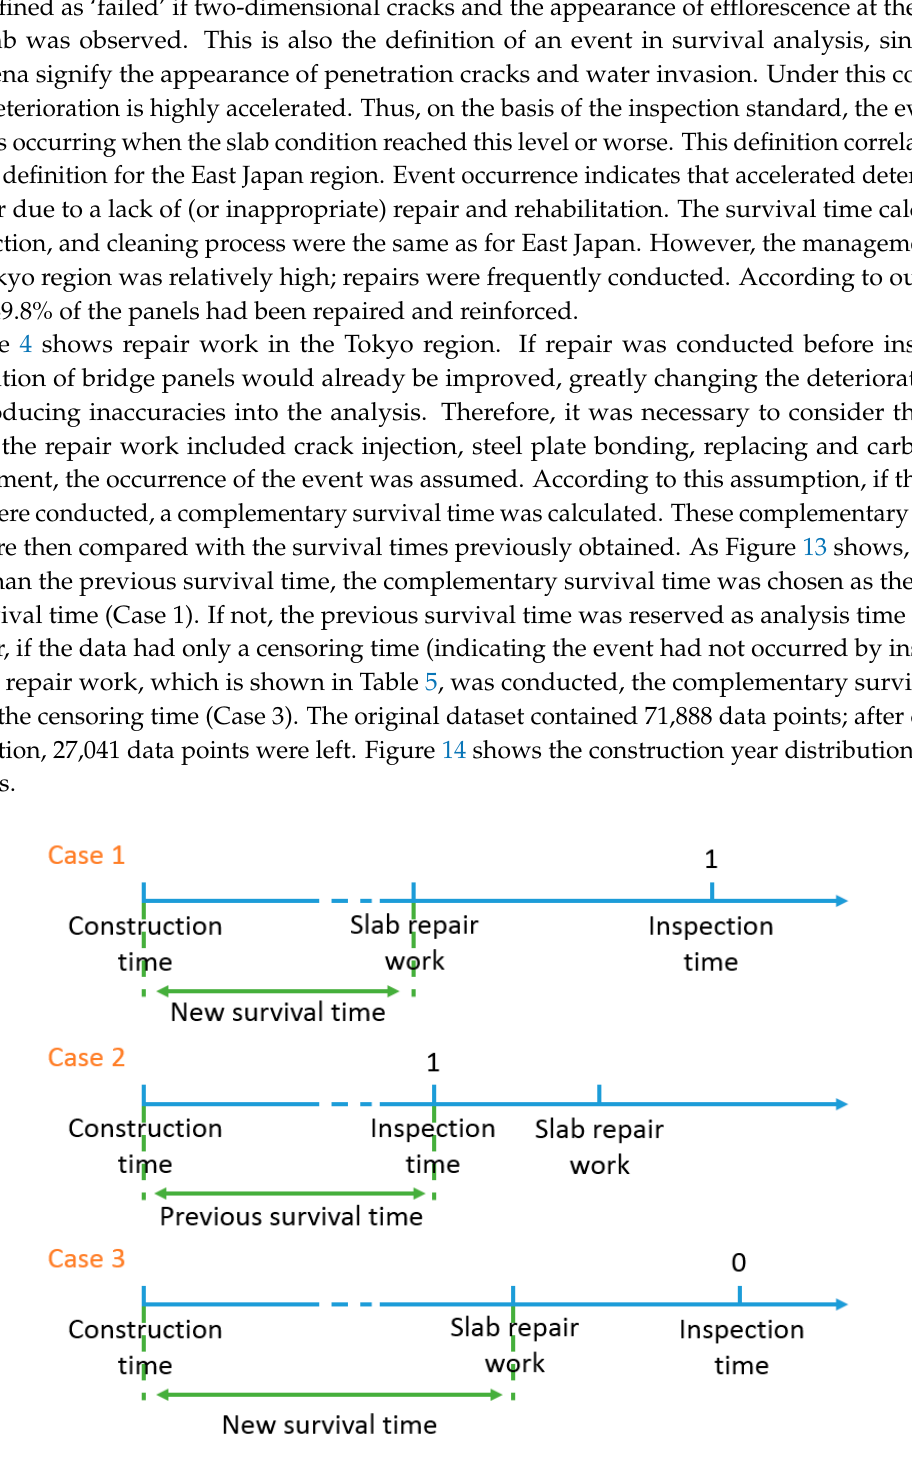
Figure 13. Survival time calculation (considering slab repair work).